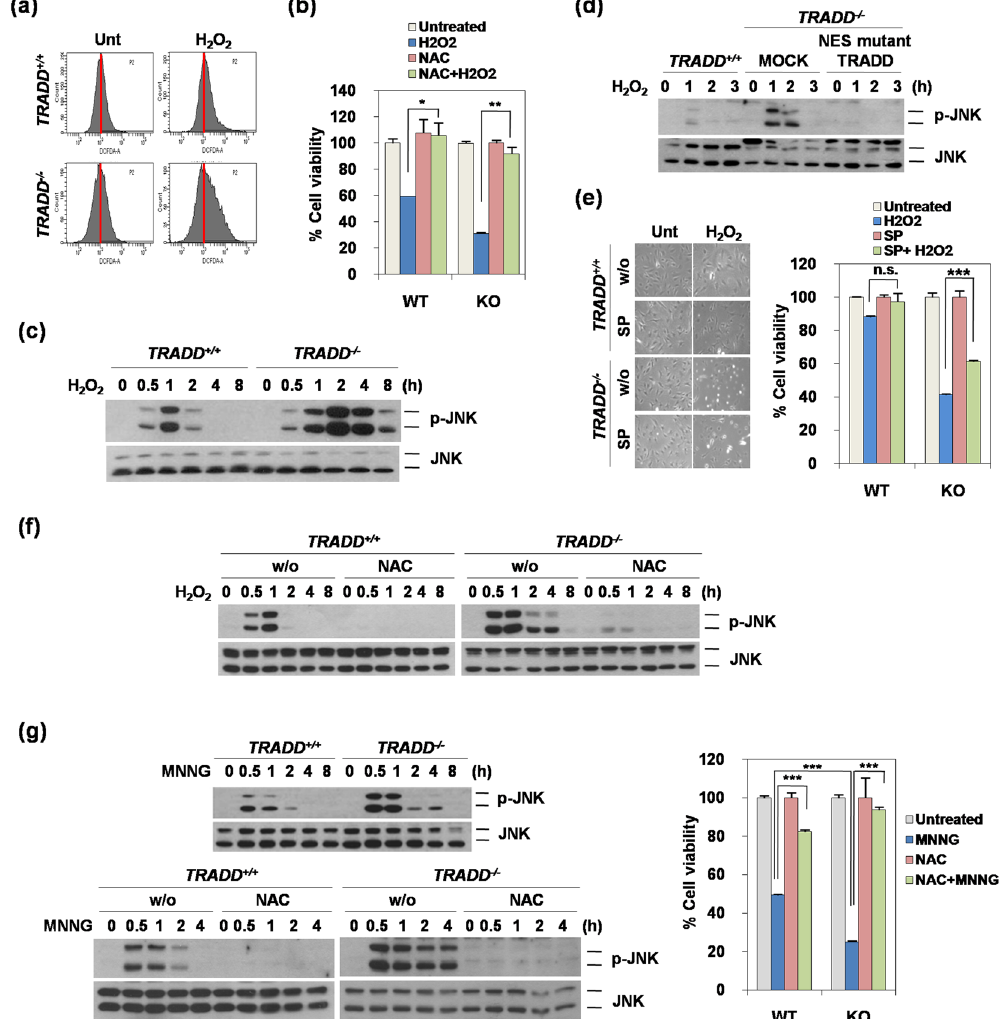
Figure 5. TRADD induces ROS accumulation and prolonged JNK activation. ( a ) TRADD + / + and TRADD − / − MEFs were pretreated with H 2 O 2 (0.5 mM) for 4 hours followed by treatment with H 2 DCFDA (10 μ M) for 30 minutes. ROS levels were measured by flow cytometry. ( b ) MTT assays of TRADD + / + (WT) and TRADD − / − (KO) MEFs treated with NAC (1 mM), H 2 O 2 (0.5 mM), or NAC (1 mM) plus H 2 O 2 (0.5 mM) for 24 hours, respectively. * P < 0.05; ** P < 0.01 (Student’s t-test). ( c ) Western blotting of lysates from TRADD + / + and TRADD − / − MEFs treated with H 2 O 2 (0.5 mM) for indicated time periods. ( d ) Western blotting of lysates from TRADD + / + , TRADD − / − and TRADD − / − (NES-mutant TRADD) MEFs treated with H 2 O 2 (0.5 mM) for indicated time periods. ( e ) TRADD + / + and TRADD − / − MEFs were pretreated with JNK inhibitor (SP, 20 μ M) for 30 minutes followed by treatment with H 2 O 2 (0.5 mM) for 24 hours. Cell viability was analyzed by cell morphology and MTT assay. *** P < 0.001; n.s., not significant (Student’s t-test). ( f ) Western blotting of lysates from TRADD + / + and TRADD − / − MEFs pretreated with NAC (1 mM) for 30 minutes followed by treatment with H 2 O 2 (0.5 mM) for indicated time periods, and then analyzed by western blotting. ( g ) Western blotting of lysates from TRADD + / + and TRADD − / − MEFs treated with MNNG (0.25 mM) for indicated time periods (left upper panel). Western blotting of lysates from TRADD + / + and TRADD − / − MEFs pretreated with NAC (1 mM) for 30 minutes followed by treatment with MNNG (0.25 mM) for indicated time periods, and then analyzed by western blotting (left lower panel). MTT assays of TRADD + / + and TRADD − / − MEFs treated with NAC (1 mM) and MNNG (0.25 mM) for 24 hours (right panel). *** P < 0.001 (Student’s